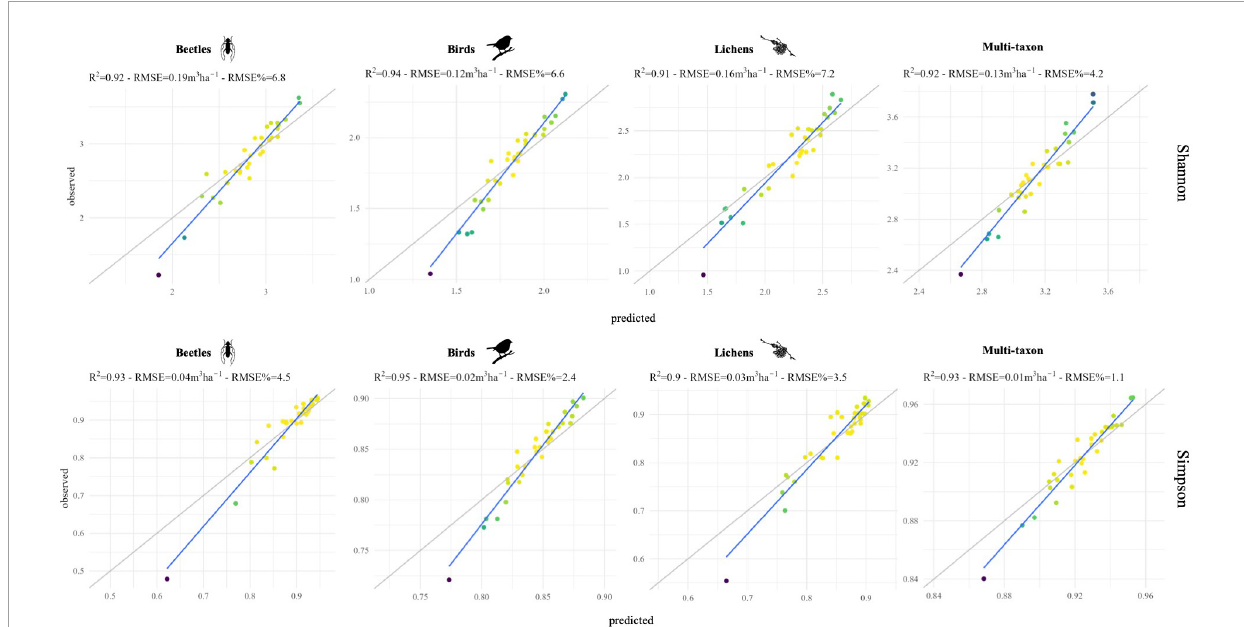
FIGURE7 Scatterplot of predicted vs. observed values for each diversity index and taxon, obtained with random forests (RF) models. Colors represent the point